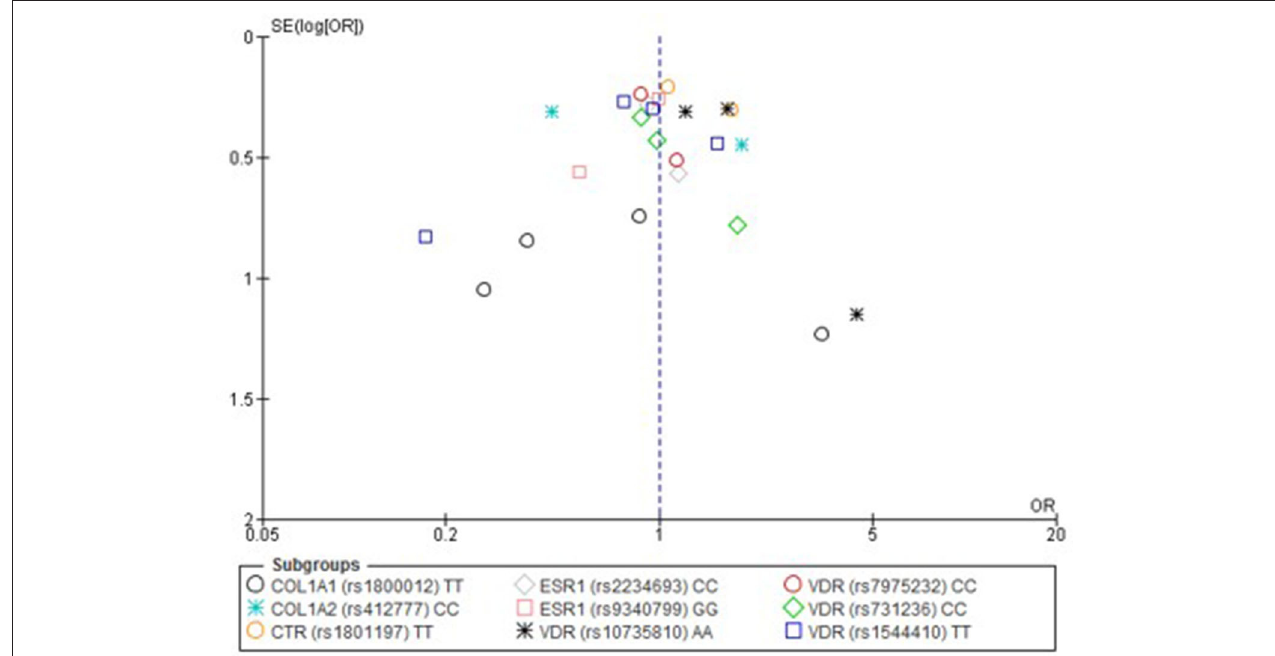
FIGURE 5 | Funnel plot of single nucleotide polymorphisms replicated in studies investigating genetic association with fracture risk in physically active participants using the homozygote contrast model.